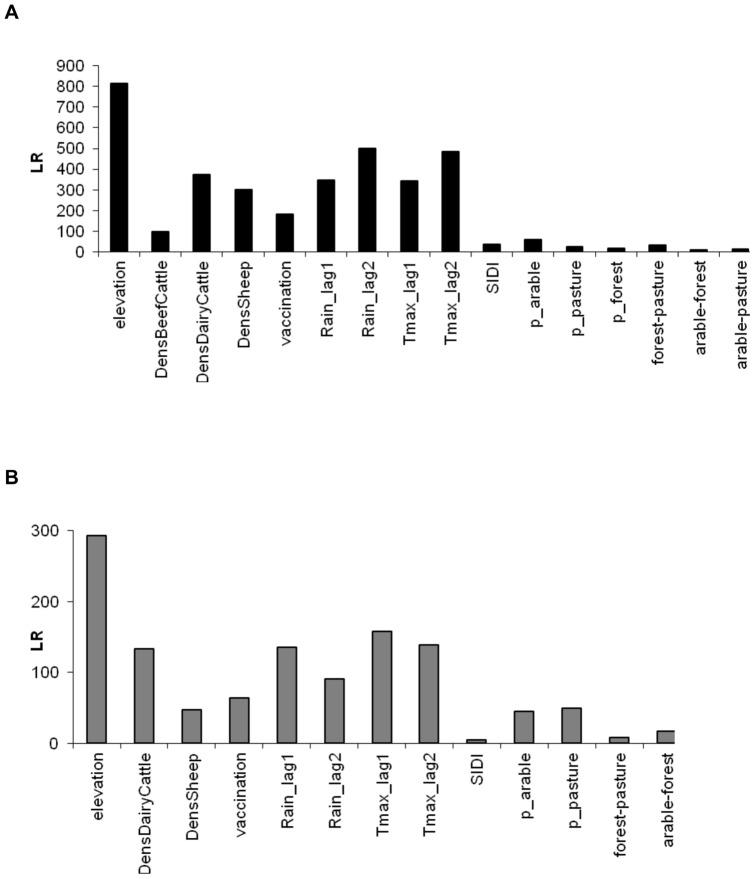
Likelihood ratio (LR) statistics for environmental variables in A) OLS and B) SARerr models.Larger LR values indicate a greater contribution to model fit. P-values and parameter estimates of the OLS and SARerr models are given in Tables S4 and 4, respectively. See Table 1 for descriptions of environmental variables.